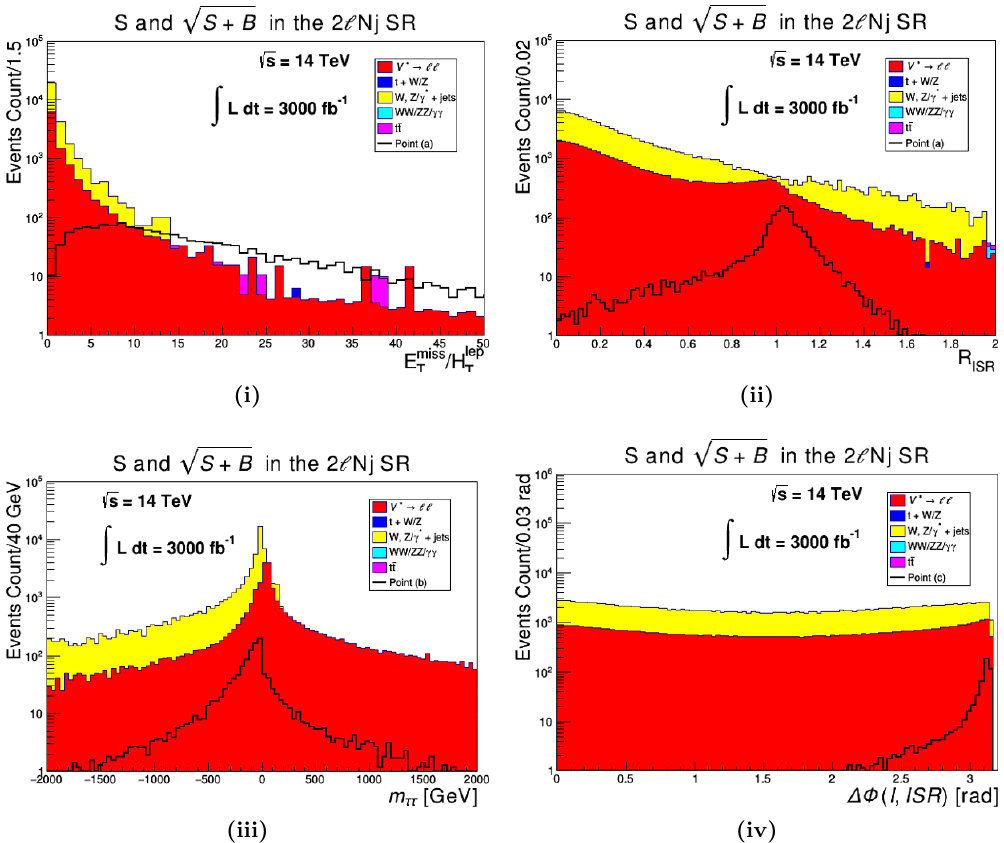
Figure 5. Distributions of four kinematic variables used in this analysis: (i) E miss R ISR ; (iii) m (cid:28)(cid:28) and (iv) (cid:1) (cid:30) (I ; ISR) for select benchmarks at 14 TeV and for 3000 fb (cid:0) 1 of integrated